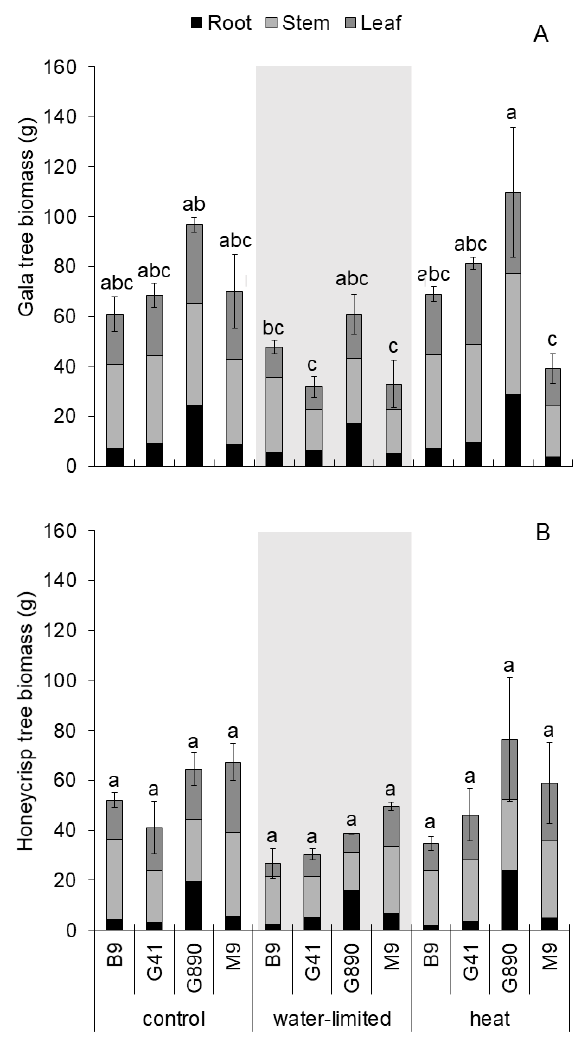
Figure 4. Mean tree biomass (grams of dry weight) distribution between roots, stems and leaves for ( A ) ‘Gala’ and ( B) ‘Honeycrisp’ apple cultivars grafted on B9, G41, G890 and M9 rootstocks grown under water-limited or elevated soil temperature treatments compared to an untreated control. Error bars denote standard error for total tree biomass ( n = 3). Letters denote significant differences among means determined using a Tukey’s mean separation test ( α = 0.05).